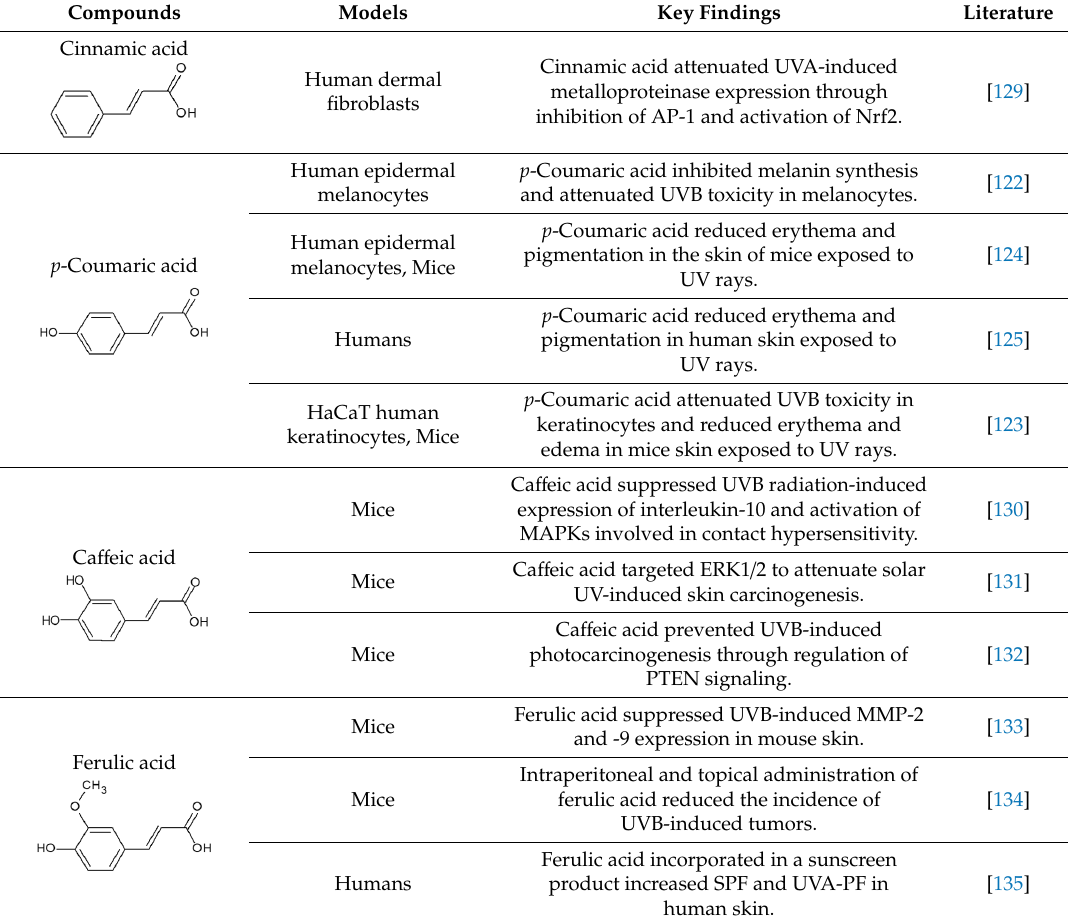
Table 3. Protective e ff ects of phenyl propanoids against UV-induced toxicity.